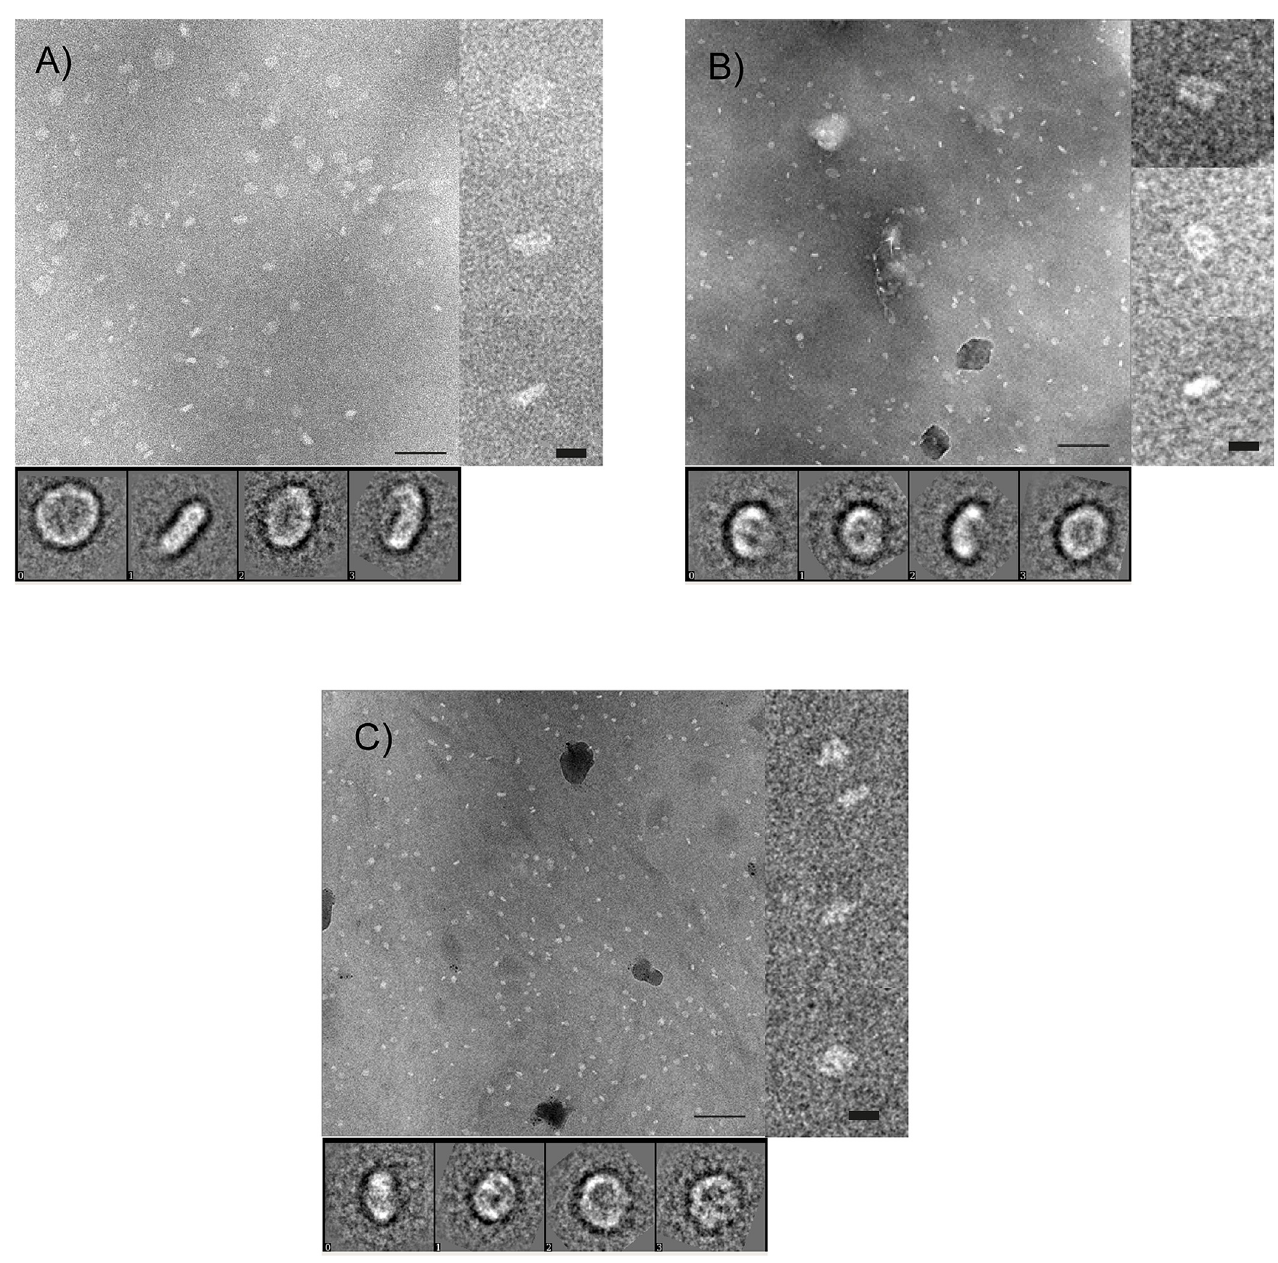
Fig 5. Negative stain TEM indicates formation of 5LO-FLAP nanodisc complexes. NaPT stained (2%) images of FND:s in the presence or absence of 5LO. The image in A) shows FND:s in the absence of 5LO. These control FND samples were not purified on a sucrose gradient, hence larger particles are present compared to the images in B and C. Here the FND:s were mixed with 5LO and either B) arachidonic acid or C) calcium ions. The samples were collected after sucrose gradient separation. Insets at right show magnified typical views of the particles. Insets below show averages after 2D-classification [27]. No stacking is observed in any image. Scale bar 100 nm, for insets to the right 10 nm and of the 2D classes the box side 26.9